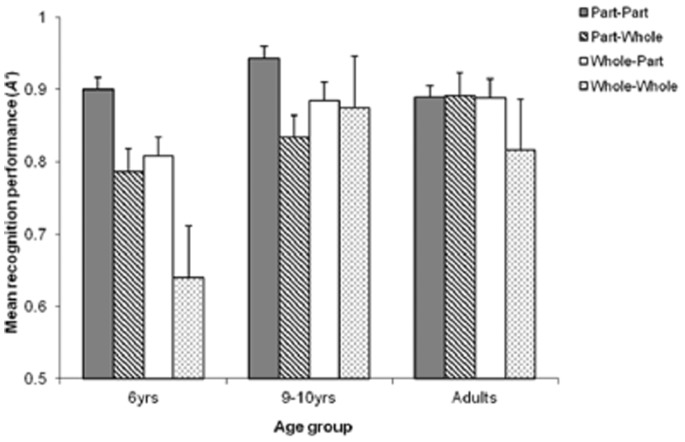
Recognition performance (A′) as a function of condition and age group.Error bars represent standard error.